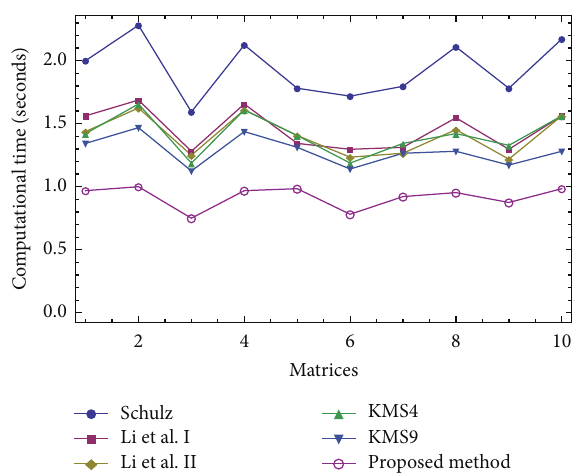
Figure 4: Comparison of the elapsed time for solving the Test Problem 1 using 𝑉 0 = 𝐴/‖𝐴‖ 2 𝐹